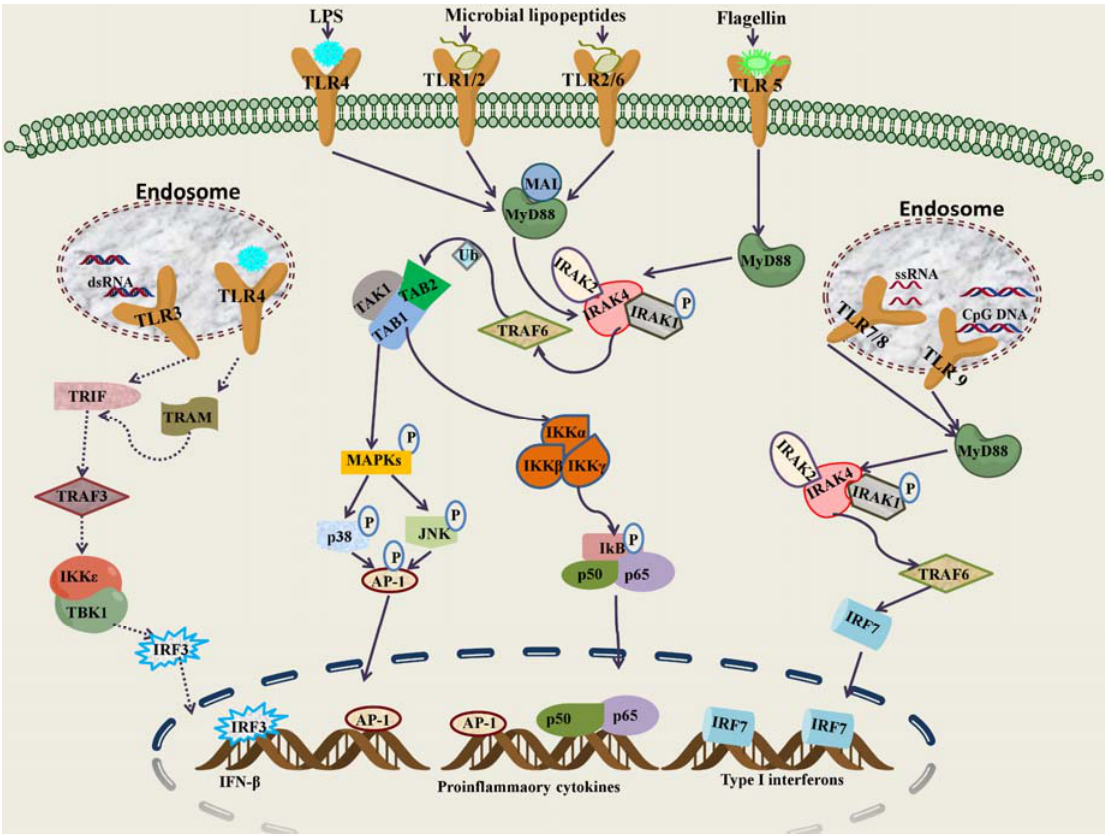
Figure 1. Toll-like receptor signaling networks. TLR1, TLR2, TLR4, TLR5, and TLR6 work at the extracellular surface and TLR3, TLR7, TLR8, and TLR9 function in the endosomal/lysosomal compartments. The activation begins with the cytosolic TIR domains of receptor and adaptor proteins. Upon stimulation in MyD88-dependent pathways, MyD88 recruits IRAK4 through the death domain interactions. IRAK4 phosphorylates IRAK1, which associates with TRAF6. TRAF6 activates the TAK1 protein associated with TAB1 and TAB2. TAK1 phosphorylates the IKK complex, thereby activating NF- κ B subunits, which translocate to the nucleus. TAK1 also activates MAPKs, resulting in the phosphorylation of JNK and p38, which finally culminate in the activation of AP-1. AP-1 and NF- κ B induce proinflammatory cytokines such as IL-1, IL-12, and TNF- α . In MyD88-independent pathways, TRIF induces IFN- β and IFN-inducible genes through the activation of TRAF3. Stimulation of TLR7, TLR8, and TLR9 induces IRF7, leading to